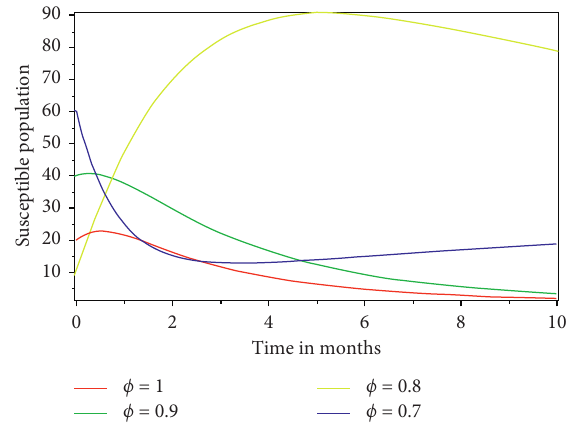
Figure 1: Approximate solution of susceptible cows.